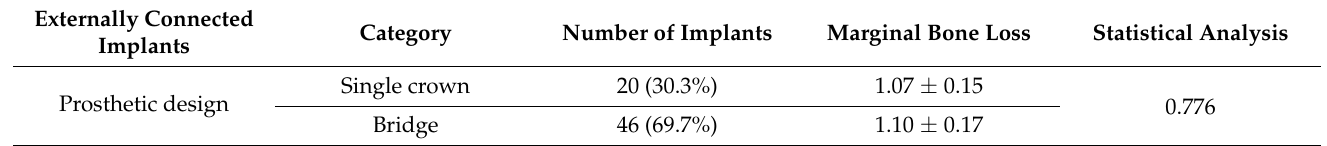
Table 2. Category, number of implants, marginal bone loss, and statistical analysis concerning externally connected implants divided according to prosthetic design.